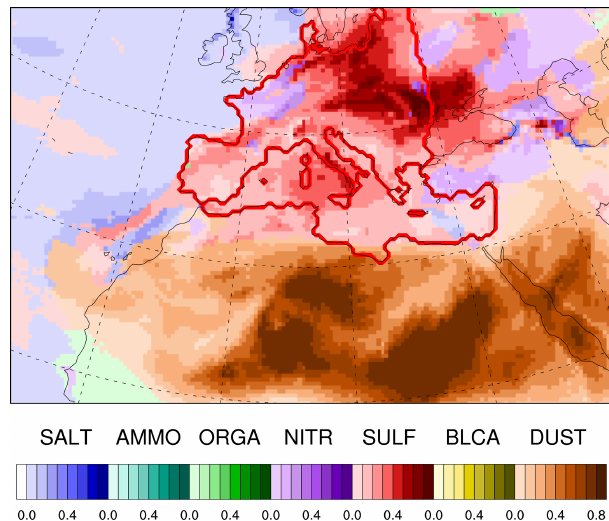
Figure 1. AOD of the dominant aerosol species (sea salt, ammo- nium, organic carbon, nitrate, sulfate, black carbon and dust) at each point over the Euro-Mediterranean region (28 August 1974). The in- ner model domain, without the bi-periodization and the relaxation zones, represents 101 × 153 points. The projection type used here is the Lambert conformal projection. The two main zones used in this study, Europe and the Mediterranean Sea, are highlighted in